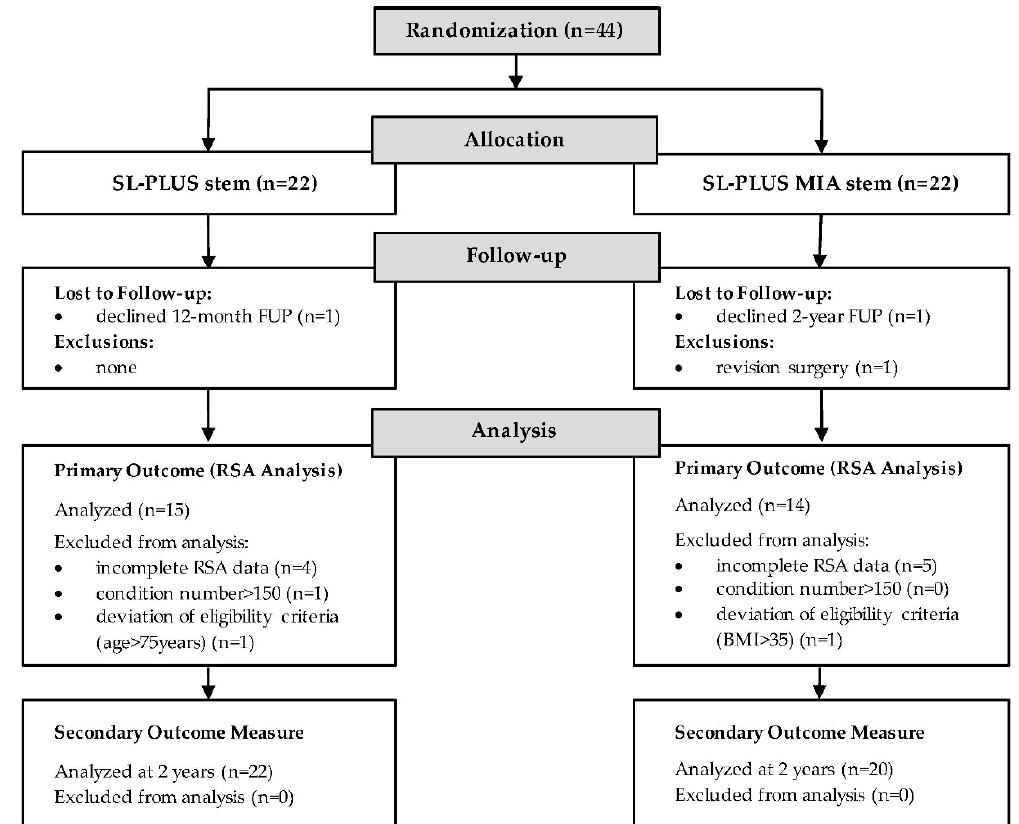
Figure 2. Flowchart demonstrating the randomization and follow-up of patients.